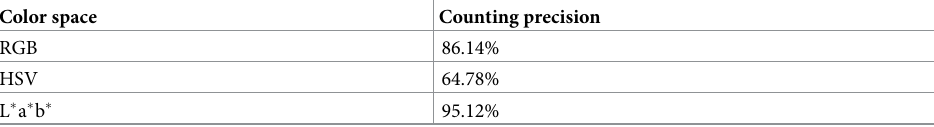
Table 3. Counting precision obtained using the RGB, HSV, and L � a � b � spaces and separating overlapping WBCs.